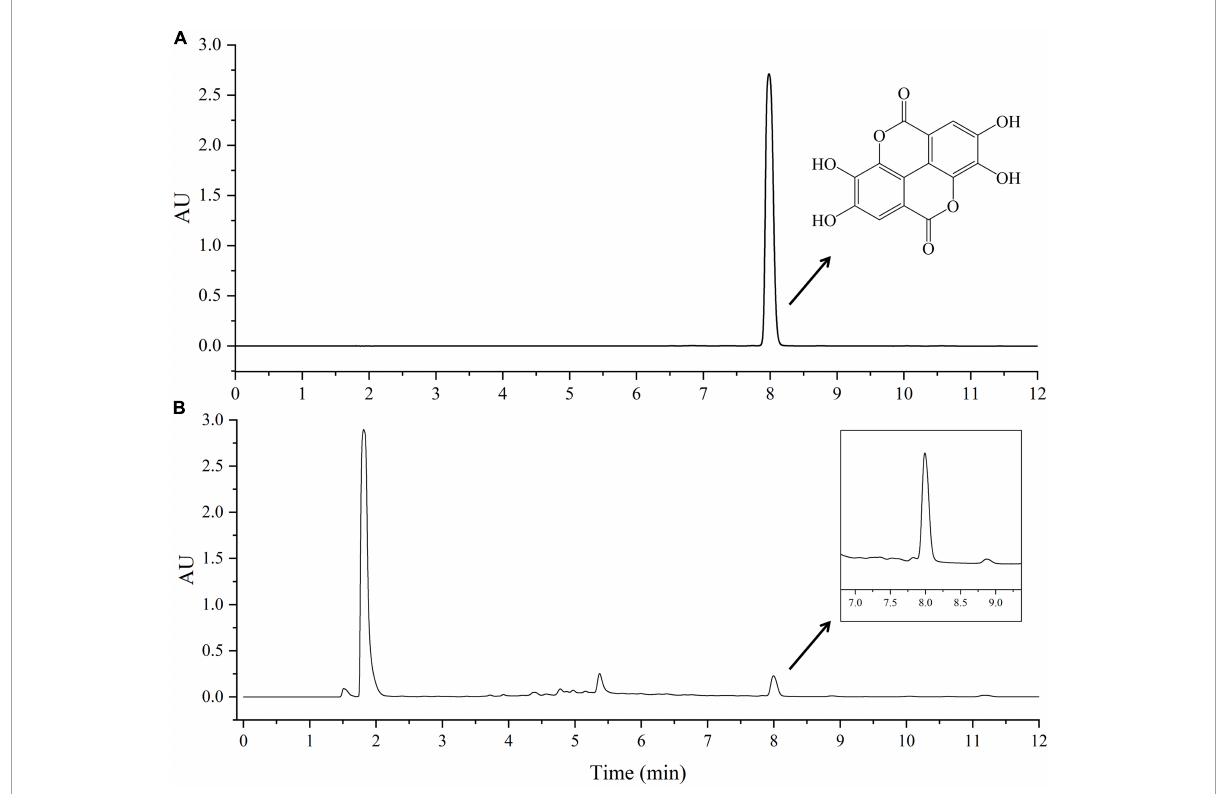
FIGURE1 High performance liquid chromatography (HPLC) chromatograms of standard ellagic acid (EA) (A) and choline chloride-oxalic acid (ChCl:Oa) extract of Geum japonicum (GJ) (B)